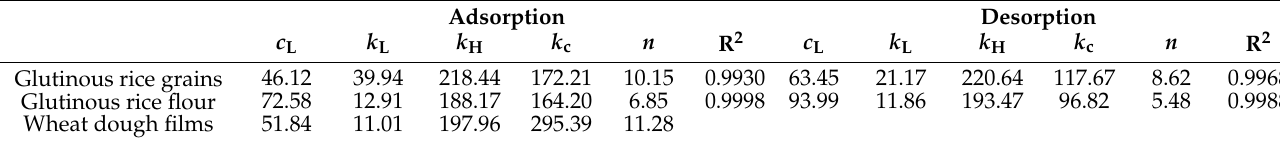
Table 1. Parameter values in the Park isotherm model for the three cereal materials.